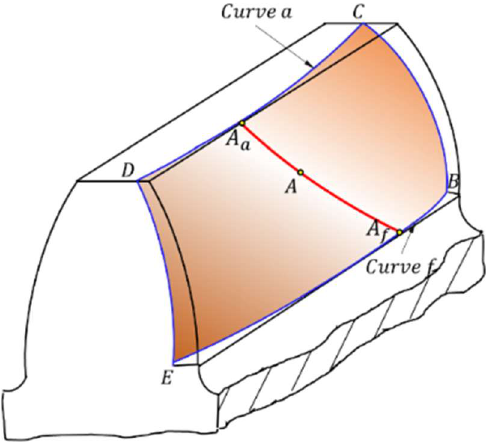
Figure 1. Twist phenomenon on tooth